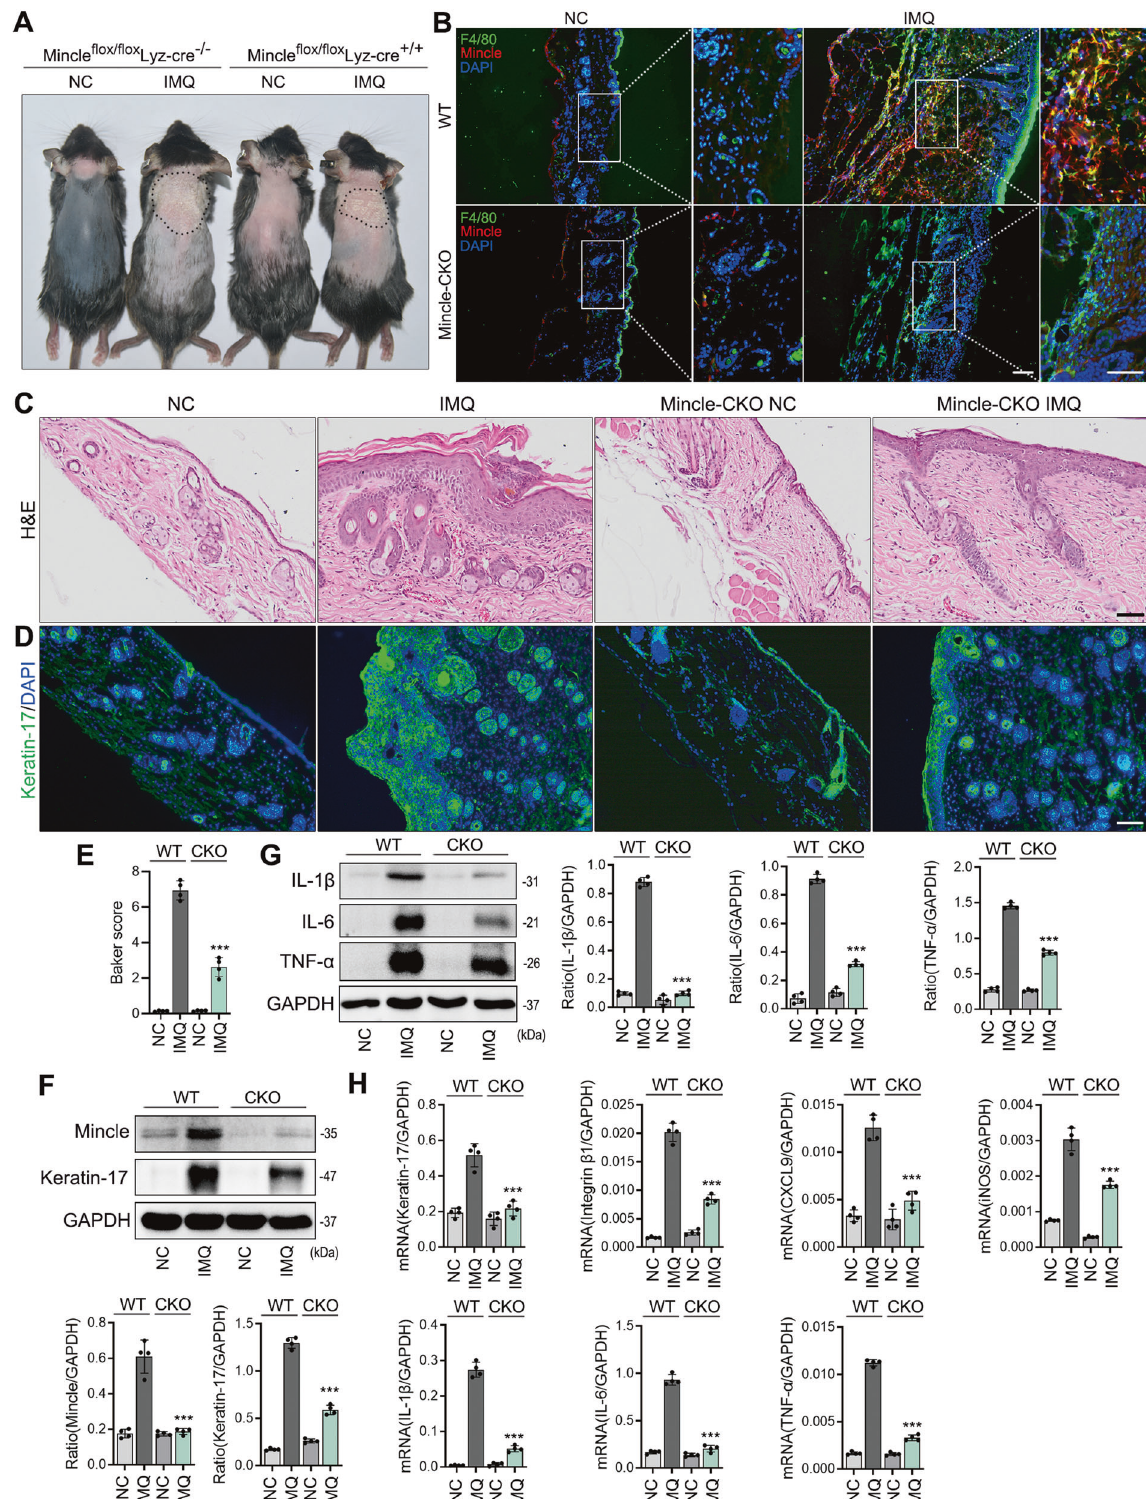
Fig. 4 Conditional deletion of Mincle from macrophages inhibits IMQ-induced psoriasis in Mincle fl ox/ fl ox /Lyz-cre + / + mice. A Psoriasis-like skin lesions induced by miquimod in WT and Mincle-KO mouse model. B Representative images of immuno fl uorescence staining of F4/80 and Mincle in WT and Mincle-KO mouse model. C H&E staining showed the histopathology of skin in WT and Mincle-KO mouse model. D Representative images of immuno fl uorescence staining of keratin-17 in WT and Mincle-KO mouse model. E Baker score of H&E staining. F Western blot showed the protein levels of Mincle and Keratin-17 in each group. G Western blot showed the protein levels of IL-1 β , IL-6 and TNF- α in each group. H Real-time PCR detected the mRNA expression of Keratin-17, Intergrin β 1, CXCL9, iNOS, IL-1 β , IL-6 and TNF- α in each group. n = 4 in each group. *** P < 0.001 vs. WT-IMQ group.